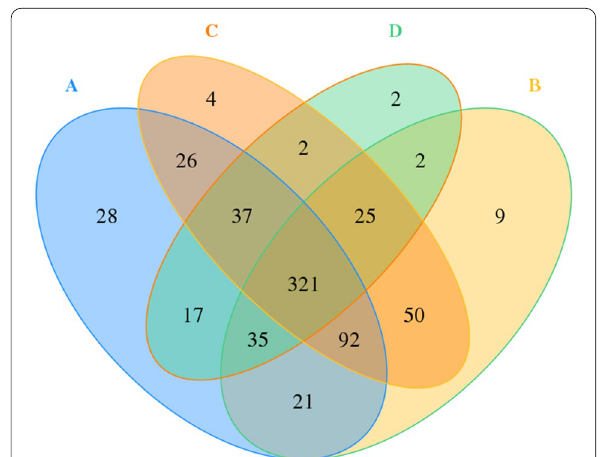
Fig. 2 Venn diagram for calculated OTUs. Different groups are presented by different colors, the number of overlapping area among graphs with different colors is the number of OTU shared by multiple samples. Non-overlapping areas show count of unique OTU of each